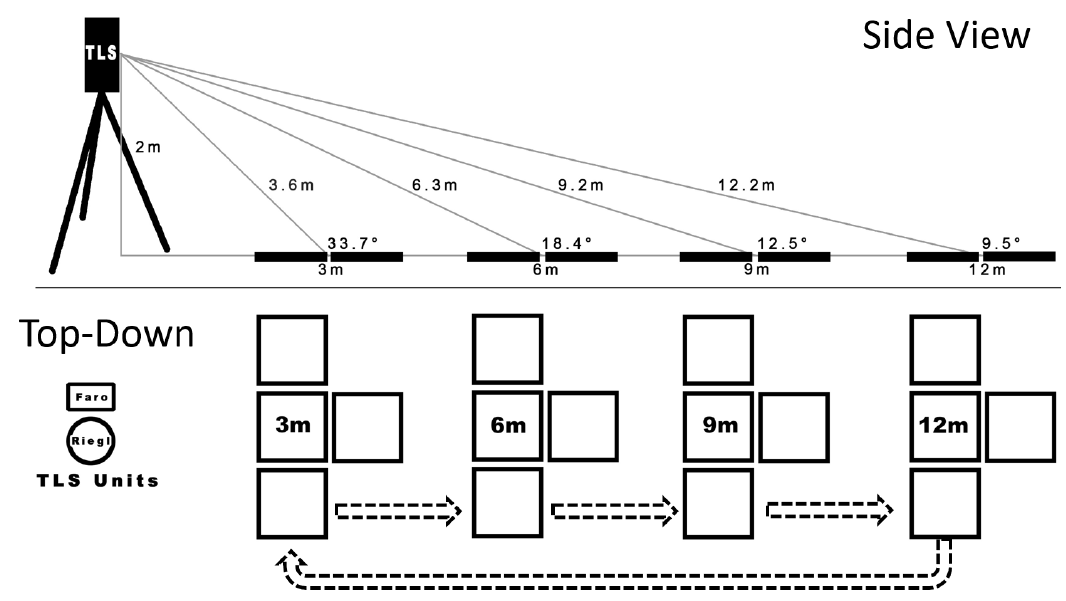
Figure 4. Layout of samples during scanning. Samples were moved in groups of 4. The arrow indicates the rotation direction used to scan every sample, at every location, at every time period. Sample orientation is referred to as 0 degrees which is perpendicular to the ground, but the angle to the scanner decreases as distance from scanner increases.